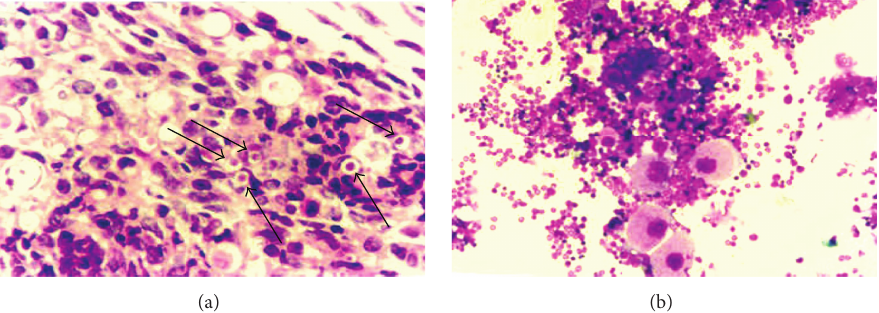
Figure5:Histologicalappearanceofmarrow:(a)conspicuouspresenceof Pb